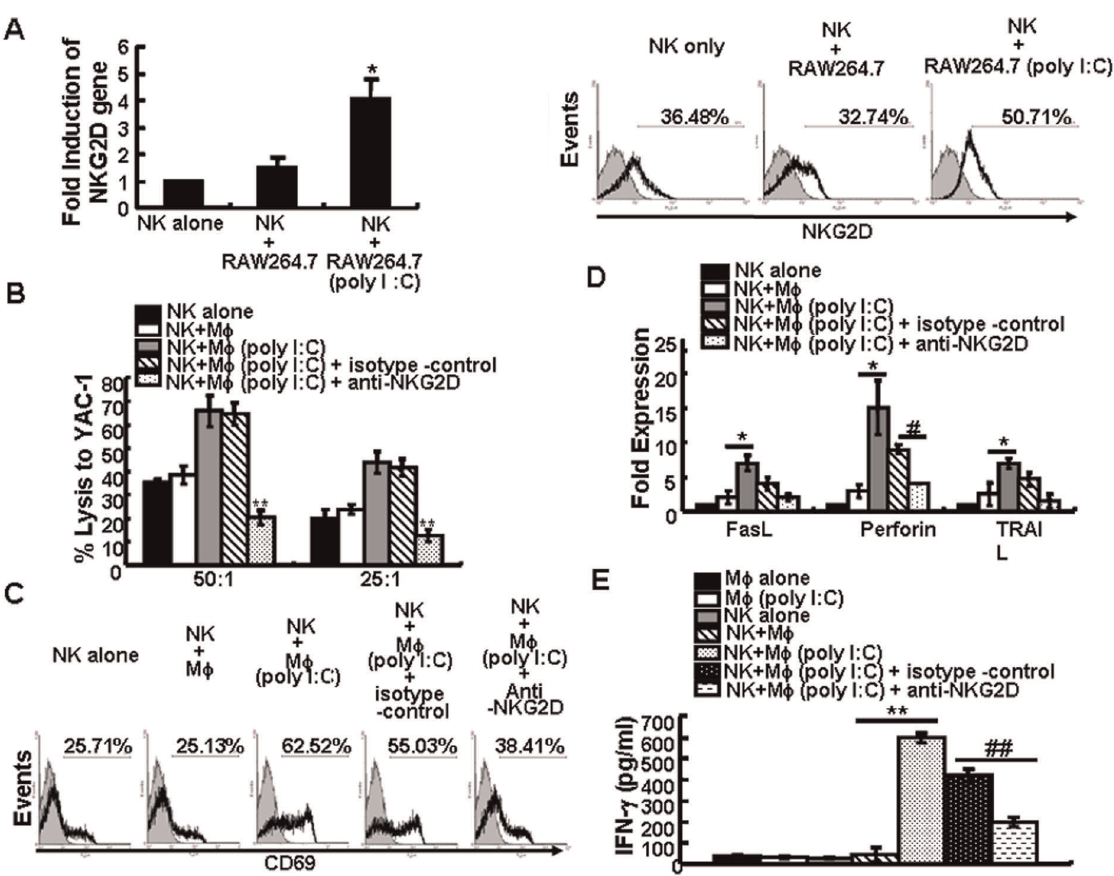
Figure 2. Poly I:C-treated macrophages enhanced NKG2D expression and NK cell function. Freshly isolated splenic NK cells were co- cultured with RAW264.7 cells that were treated with 0 or 100 m g/ml of poly I:C for 24 h. NK cells were then isolated and NKG2D expression was determined by RT-PCR and flow cytometry (A). Data are expressed as the fold change in mRNA expression normalized to untreated cells or as the percentage of positively-stained cells. * p , 0.05 versus untreated cells using the paired Student’s test. The isolated NK cells from co-culture with macrophages were co-incubated with saturating amounts of anti-NKG2D mAb or isotype control, washed and used as effector cells against YAC-1 targets (B). The expression of CD69 (C), cytotoxic effector molecules FasL, TRAIL, and perforin (D), and seceretion of IFN- c (E) were determined by flow cytometry, RT-PCR, and ELISA separately. Data are expressed as the mean 6 SD from at least three separate experiments. *p , 0.05, **p , 0.01 compared with poly I:C-untreated RAW264.7 group; # p , 0.05, ## p , 0.01 compared with isotype control group.